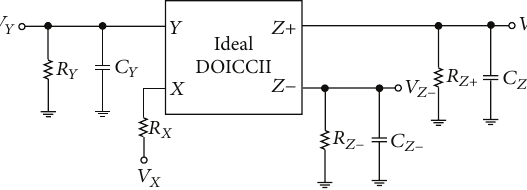
Figure 4: The nonideal DOICCII